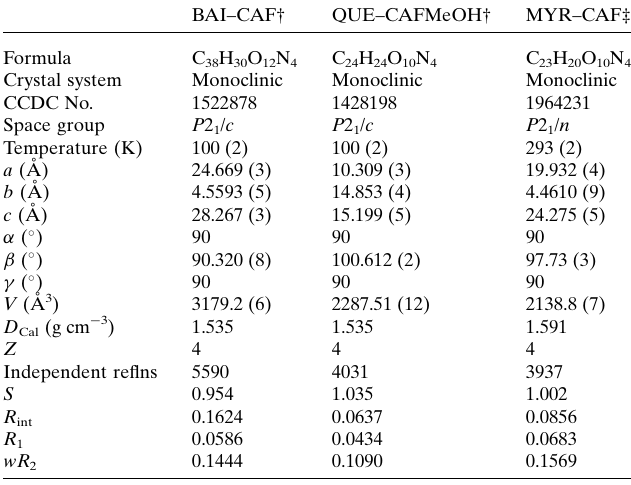
Table 1 Crystallographic data for three